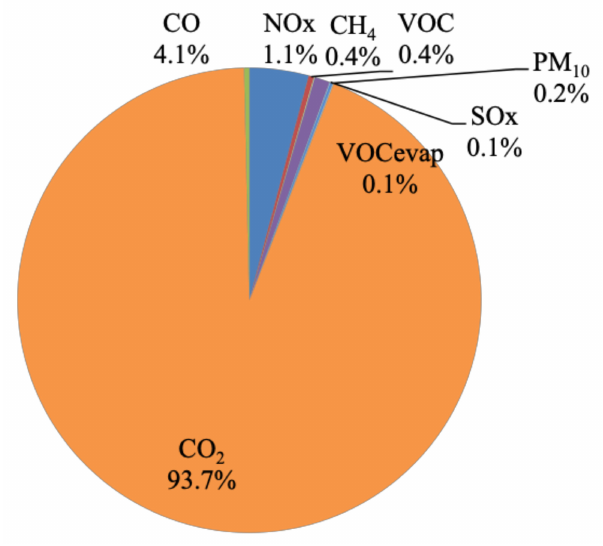
Figure 2. The distribution of different emission types as a percentage of the total quantities produced in 1 day, based in 2019-BC amounts. Toxic pollutants and N 2 O, being negligible (<0.1%), are not labeled on the pie